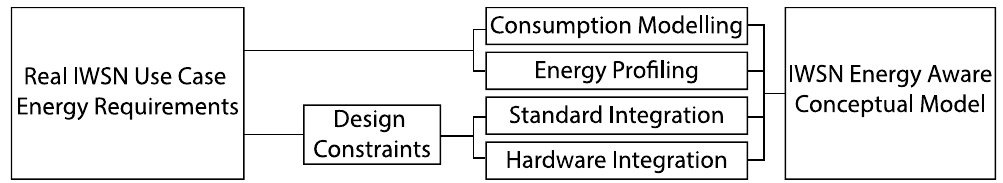
Figure 1. The top-down approach conceptual model of an IWSN energy-aware solution.